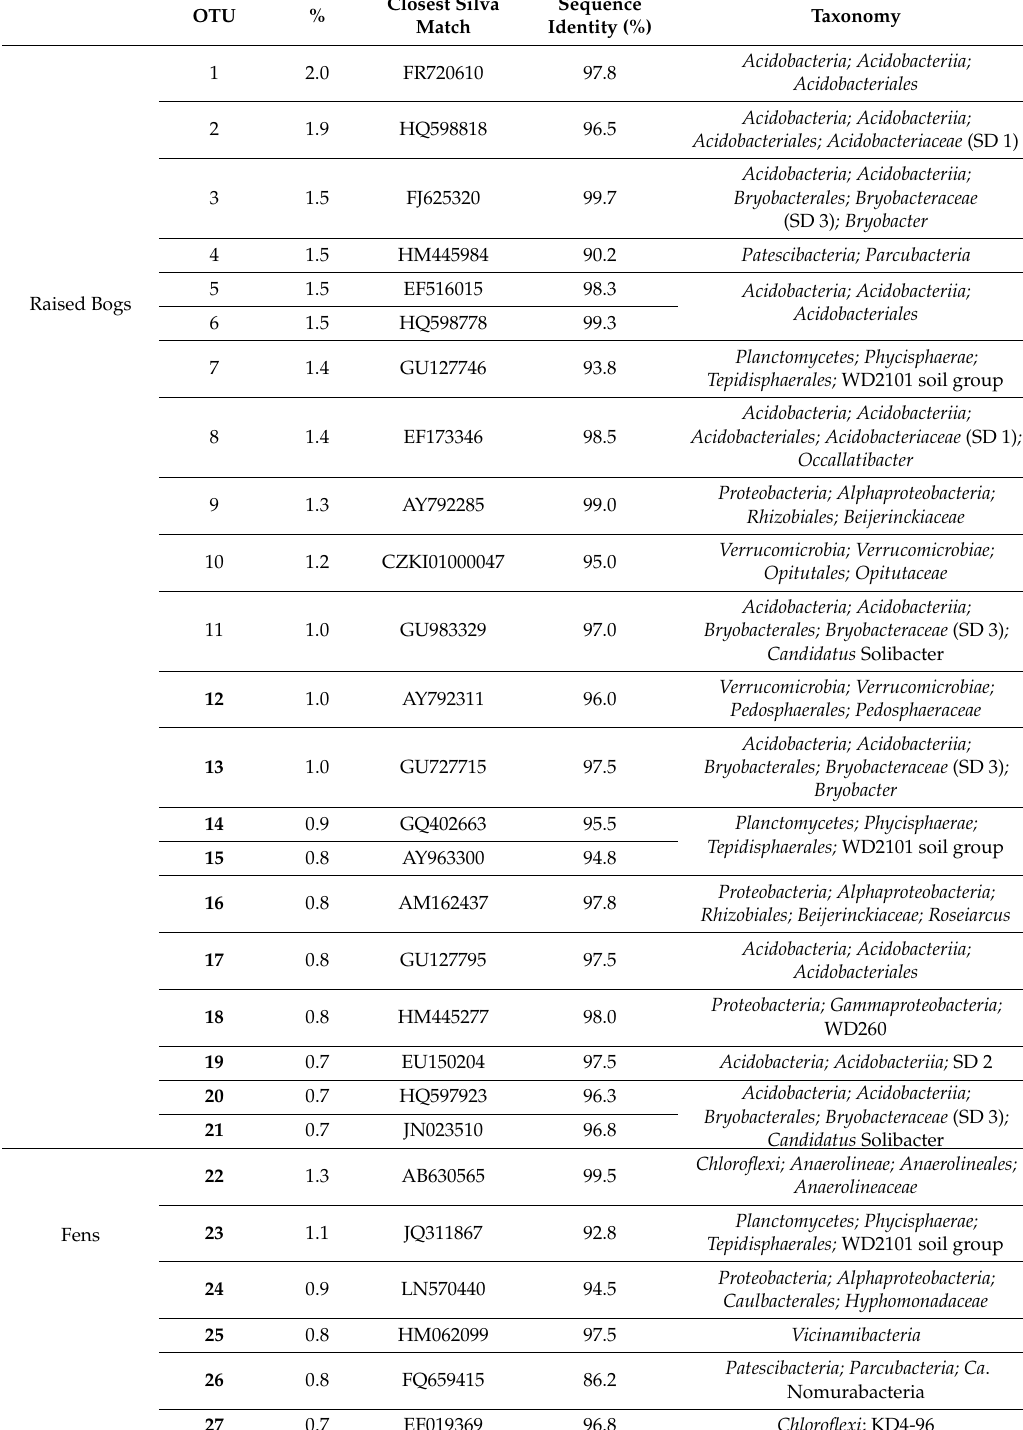
Table 3. Most abundant OTUs common for microbial communities of either peat bogs or fens. Closest Silva Sequence OTU % Match Identity (%)